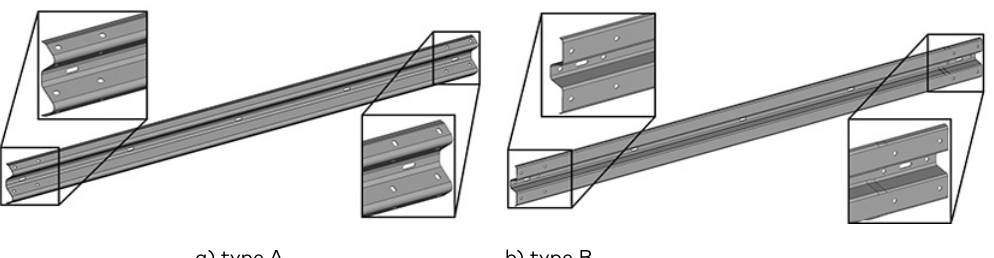
Figure 1. Guide rails of steel road safety